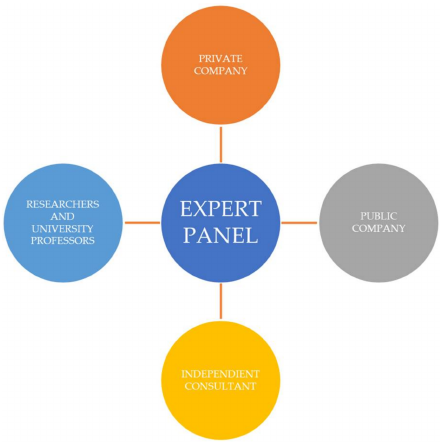
Figure 1. Expert panel composition. Source: Own elaboration.